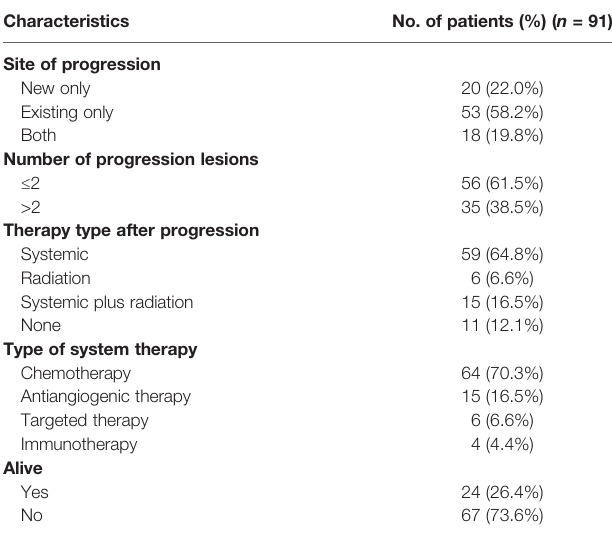
TABLE 2 | Progression characteristics.